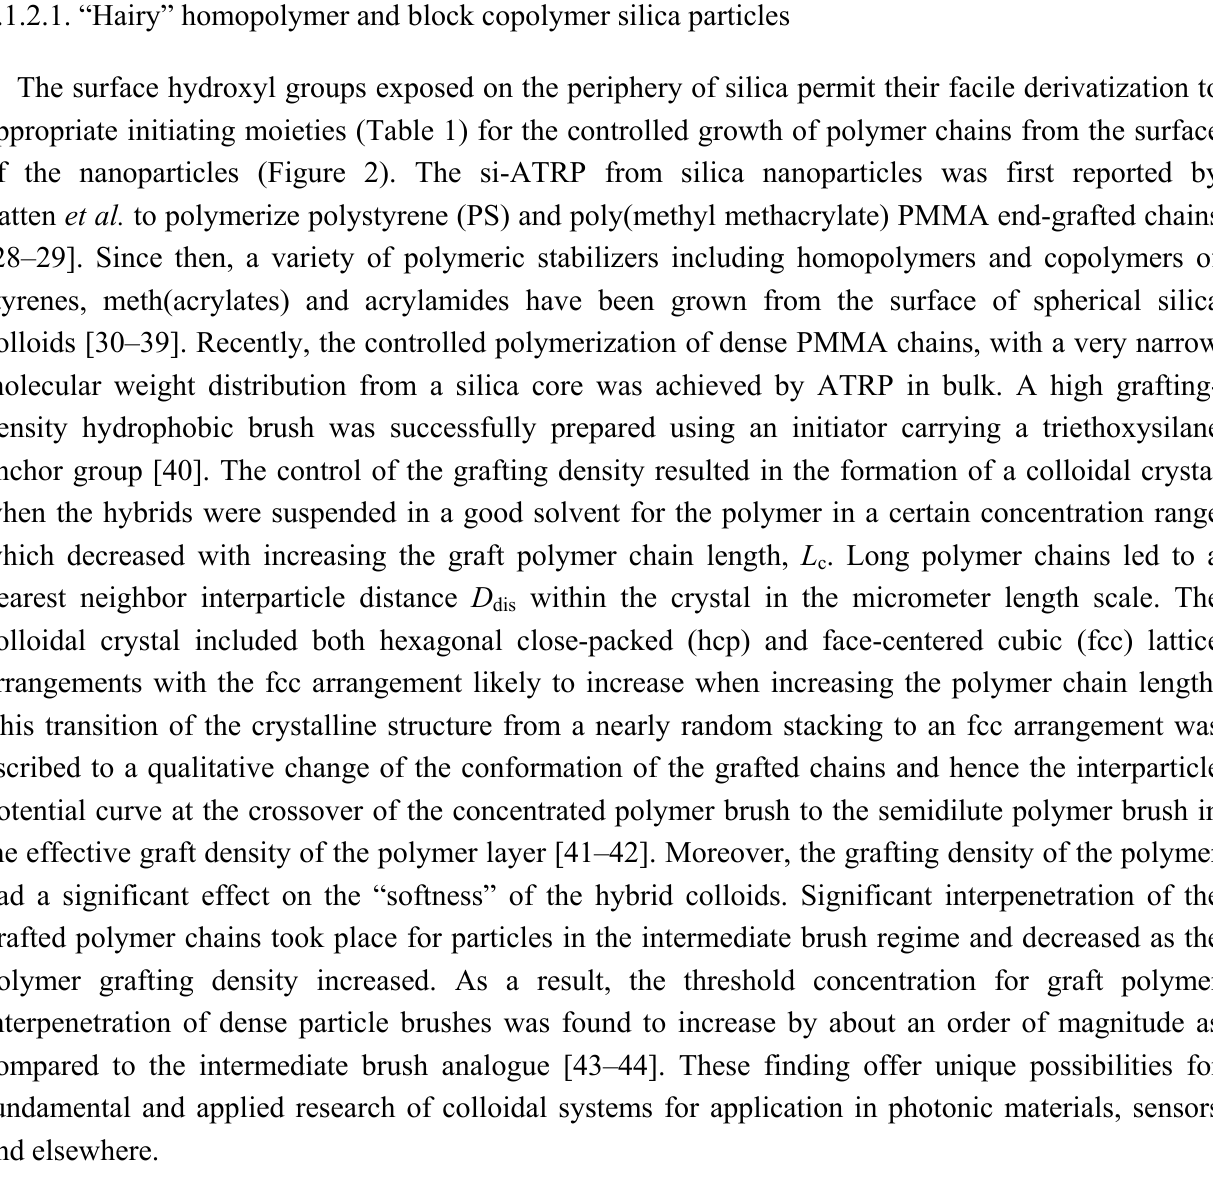
Figure 2. Schematic representation of the synthetic procedure followed for the preparation of silica-polymer core-shell hybrids using the “grafting from”